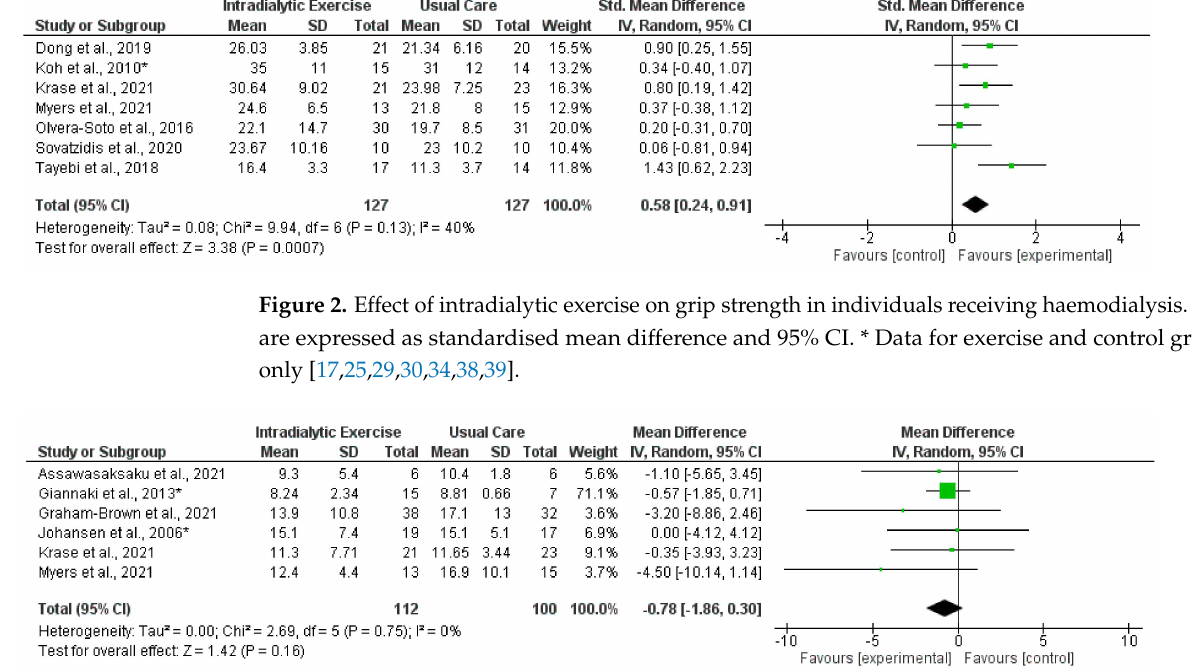
Figure 3. Effect of intradialytic exercise on sit-to-stand test 5 (seconds) in individuals receiving haemodialysis. Data are expressed as mean difference and 95% confidence interval (CI). * Data for exercise and control groups only [14–17,21,30].